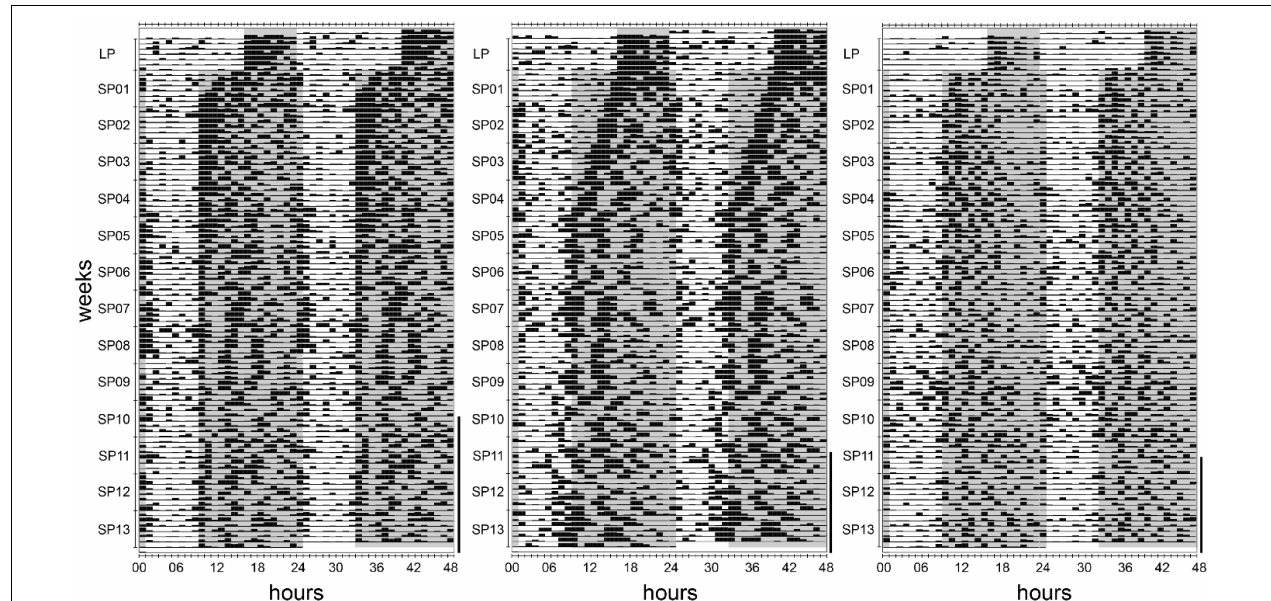
FIGURE 9 | Actograms of three individuals of approach 2 during 1 week in the long photoperiod and adaptation to the short photoperiod. Black bars indicate the activity performed within an hour, while values from 0 to 10 cpm are displayed. The long photoperiod (LP) and short photoperiod (SP) scotophases are indicated with gray areas . The days following the first torpor bout are marked with a vertical line on the right side of each actogram. All 11 hamsters adapted gradually to the immediate change from LP to SP, however at different paces. The left actogram (hamster #07) serves as an example for the majority of hamsters that showed a fast adaptation within days. The middle actogram (hamster #09) represents one of two hamsters with a gradual adaptation within weeks. The right actogram represents one of two hamsters showing a fast adaptation, but a very low activity level that impeded the analysis of temporal activity organization (hamster